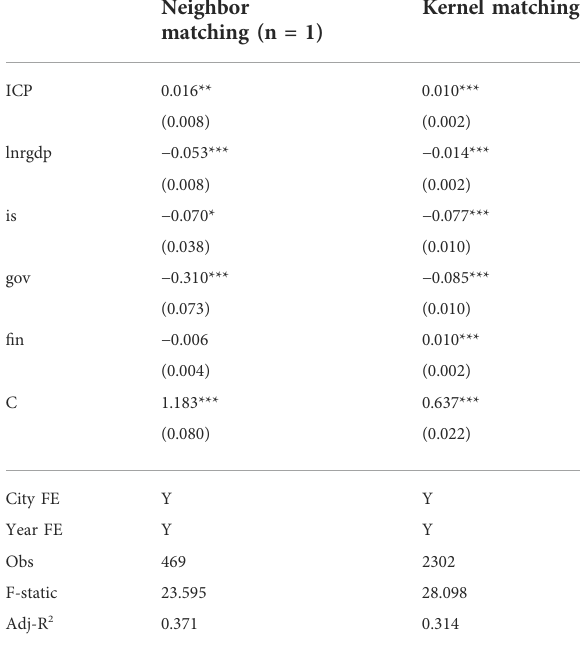
TABLE 10 Re-estimation excluding contemporaneous policy